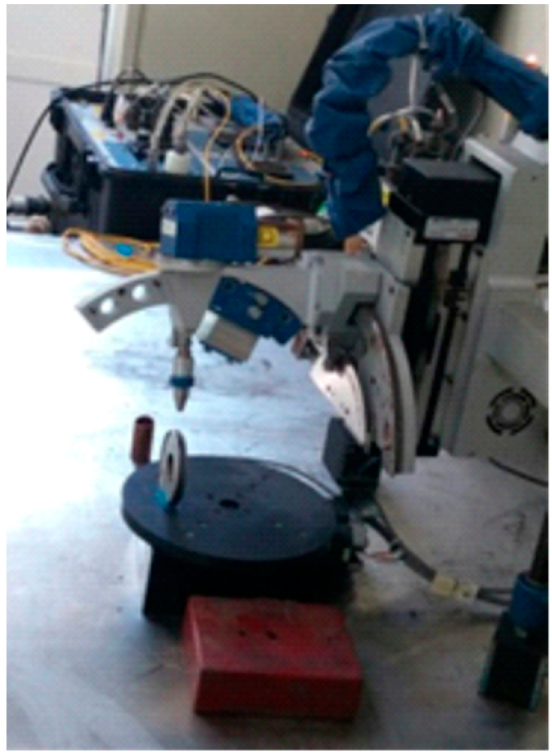
Figure 24. Residual stress measurement.